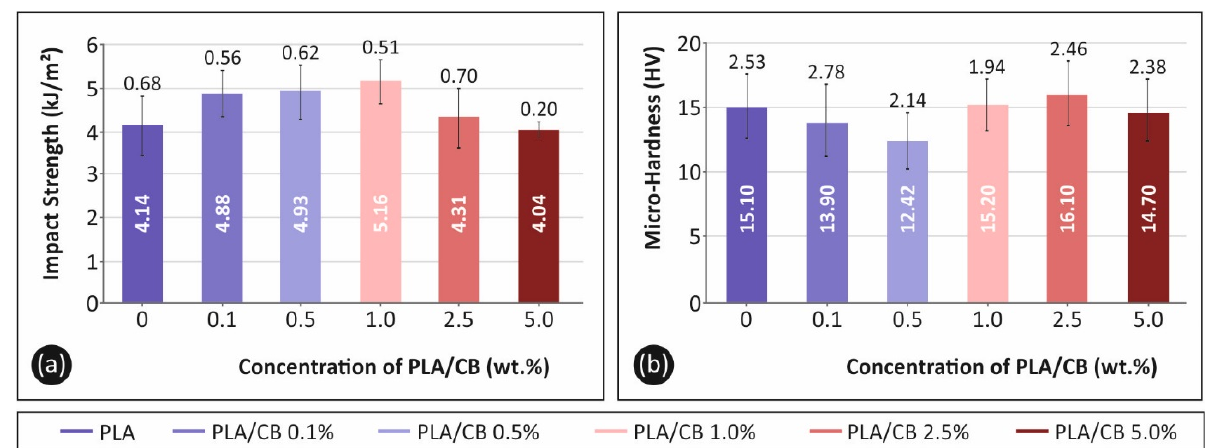
Figure 10. ( a ) Charpy’s notched impact strength test results (kJ/m 2 ), and ( b ) micro-hardness (Vickers (HV)) performance of the neat PLA compared to the PLA/CB nanocomposites (both properties are shown as the calculated average values together with their corresponding standard deviation).